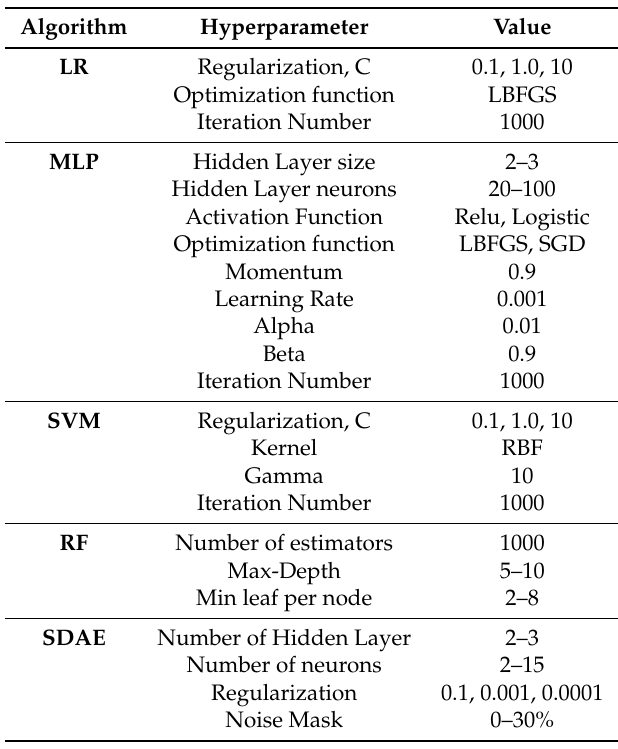
Table 2. Hyperparameters used for each algorithm and the potential values used in the grid